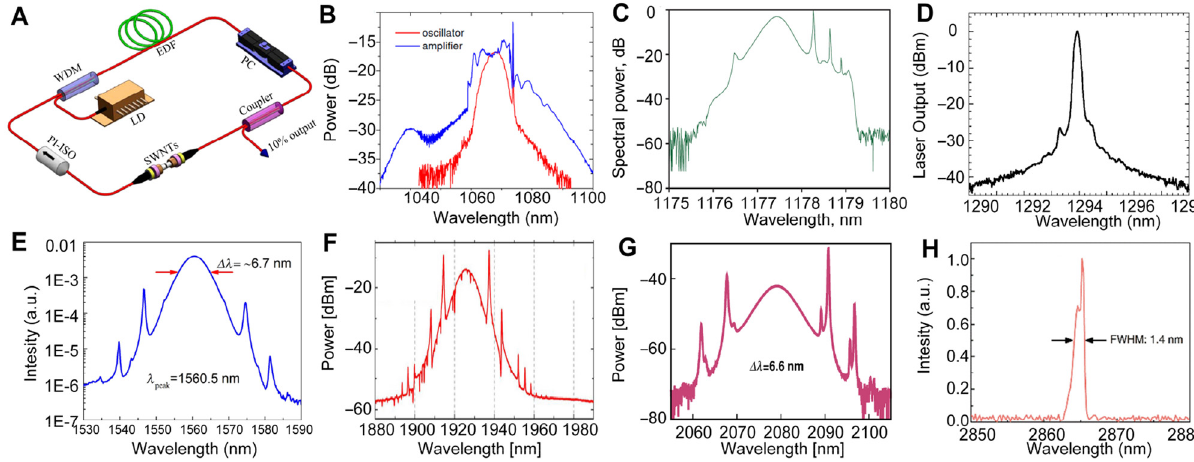
Figure 4: CNT-SA mode-locked fiber laser covering the spectral region from near-infrared to mid-infrared: (A) typical schematic diagram of CNT-SA mode-locked fiber laser. Yao et al. [123]. © IOP Publishing 2014; (B) ∼ 1000 nm using Yb-doped fi ber laser. Nicholson et al. [38]. © Optical Society of America 2007; (C) 1177 nm using Bi-doped fi ber laser. Kelleher et al. [124]. © IOP Publishing 2010; (D) ∼ 1300 nm using Pr- doped fi ber laser.Songetal. [125]©IEEE 2005;(E) ∼ 1550nmusingEr-doped fi ber.Liet al.[64].©SpringerNatureLimited2018; (F) ∼ 1900nm usingTm-doped fi berlaser.Sobonetal.[126].©SpringerNatureLimited2017;(G) ∼ 2100nmusingHo-doped fi berlaser.PAWLISZEWSKAetal. [127]. © Optical Society of America 2019; (H) mid-infrared using Ho/Pr-codoped ZBLAN fi ber laser. Wei et al. [53]. © IEEE